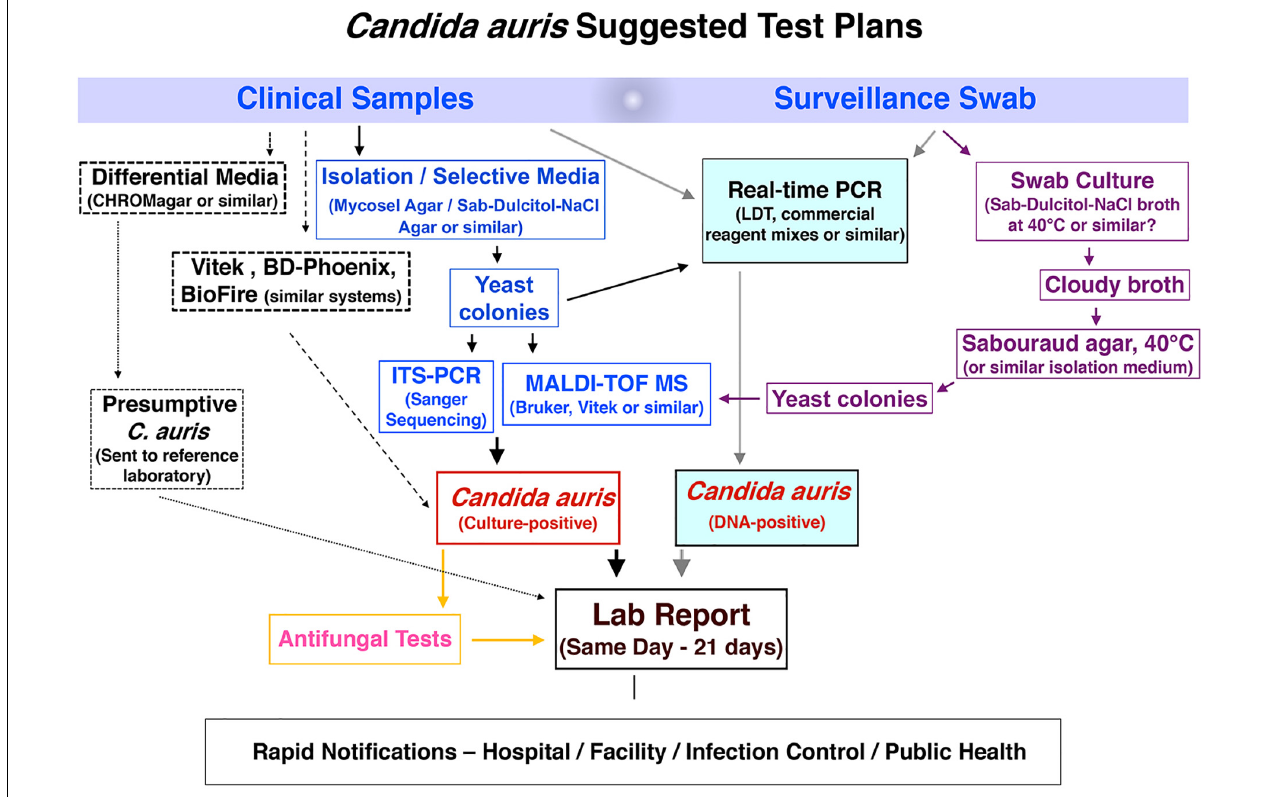
FIGURE 2 | Workflow algorithm for high-volume surveillance and clinical sample testing of C. auris . Dotted lines indicate alternate laboratory